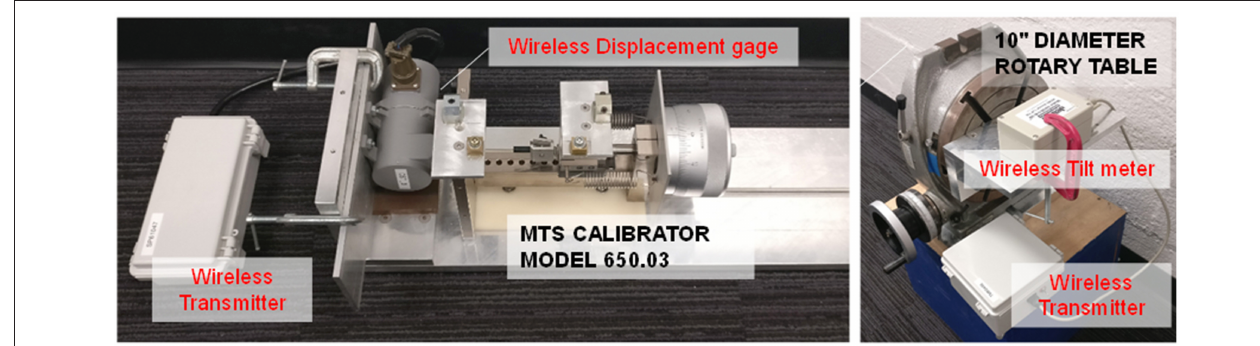
sensing system caused by the traffic loading as well as caused by temperature changes during the period of